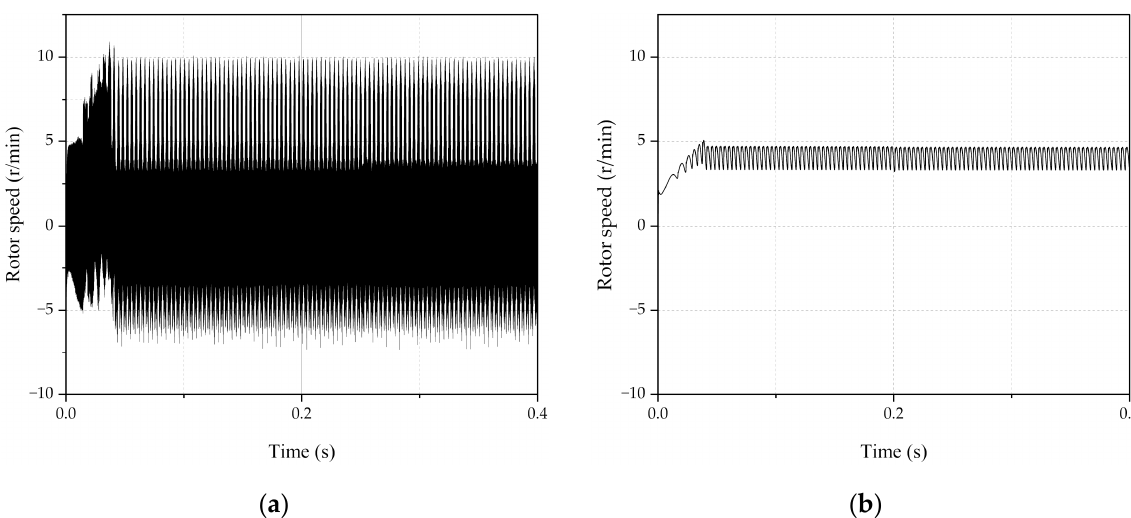
Figure 5. Simulation results of speed error. ( a ) Traditional SMO, ( b ) new SMO.